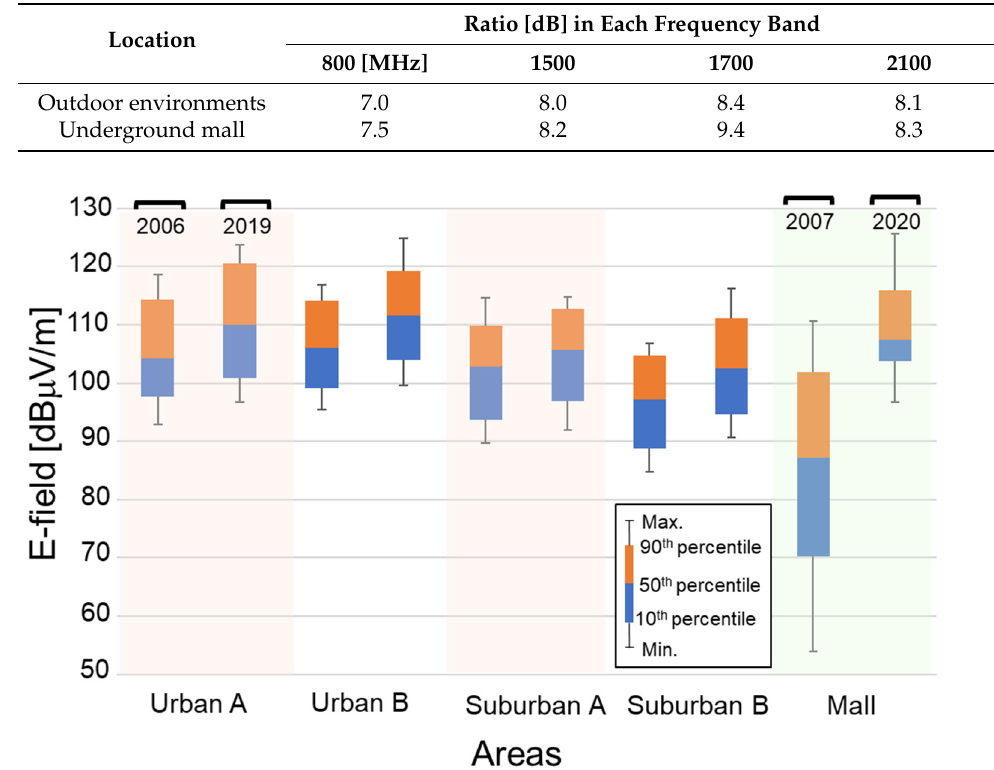
Table 4. Ratio of the maximum E-field strength to the time-averaged E-field strength.